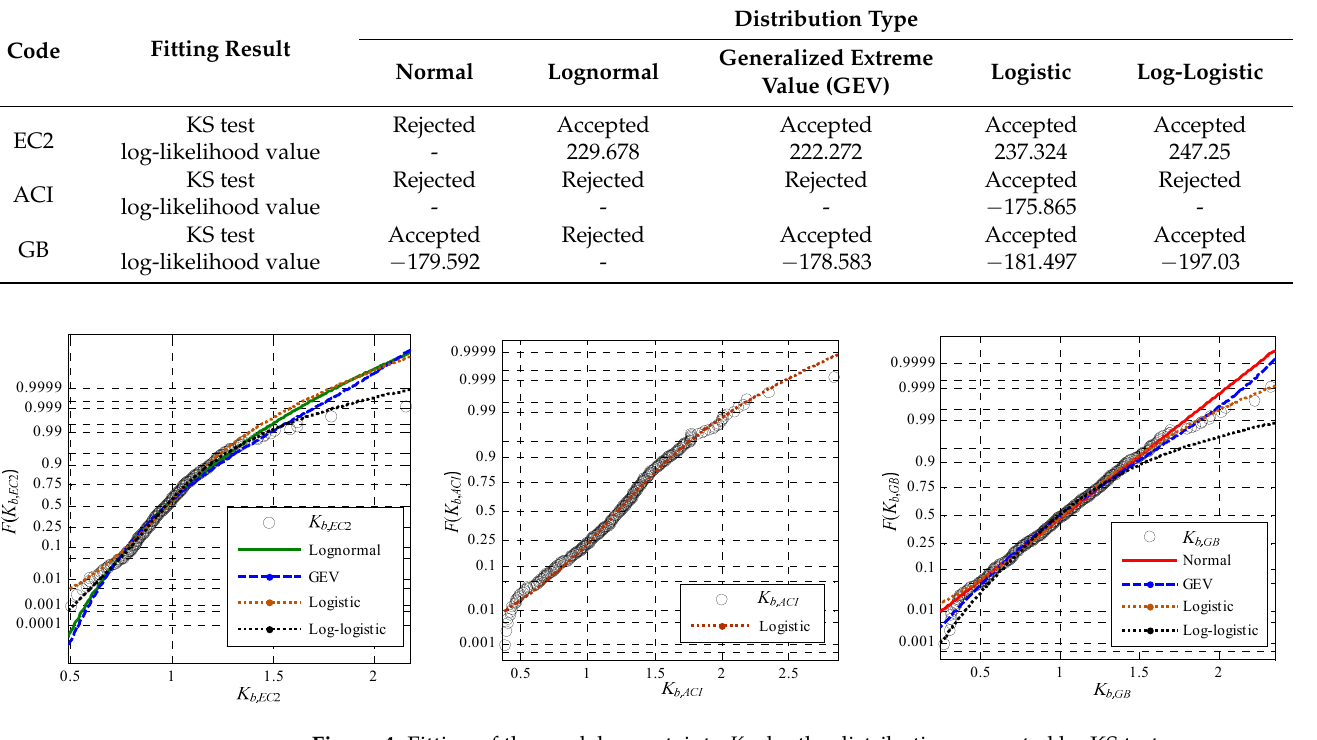
Figure 4. Fitting of the model uncertainty K pb by the distributions accepted by KS test. Table 3. Parameter estimation for the logistic distribution of model uncertainty K pb .